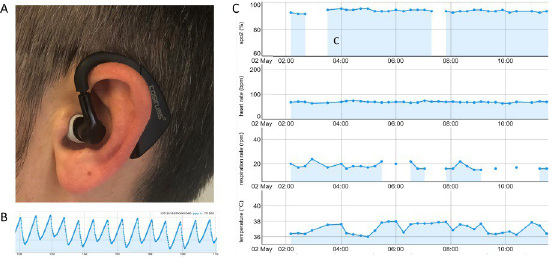
Fig 1. In-ear monitoring device and measurements. A: Device placed in the external ear canal; B: undisturbed photoplethysmogram (PPG), used for quality control; C: Section of the course of a patient’s vital signs (SpO2, heart rate, respiratory rate and core temperature) over the course of several